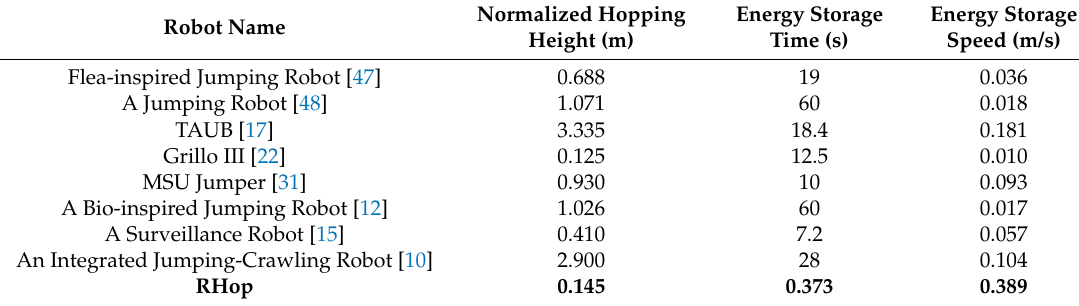
Table 4. Comparison of hopping performance of existing electrically driven